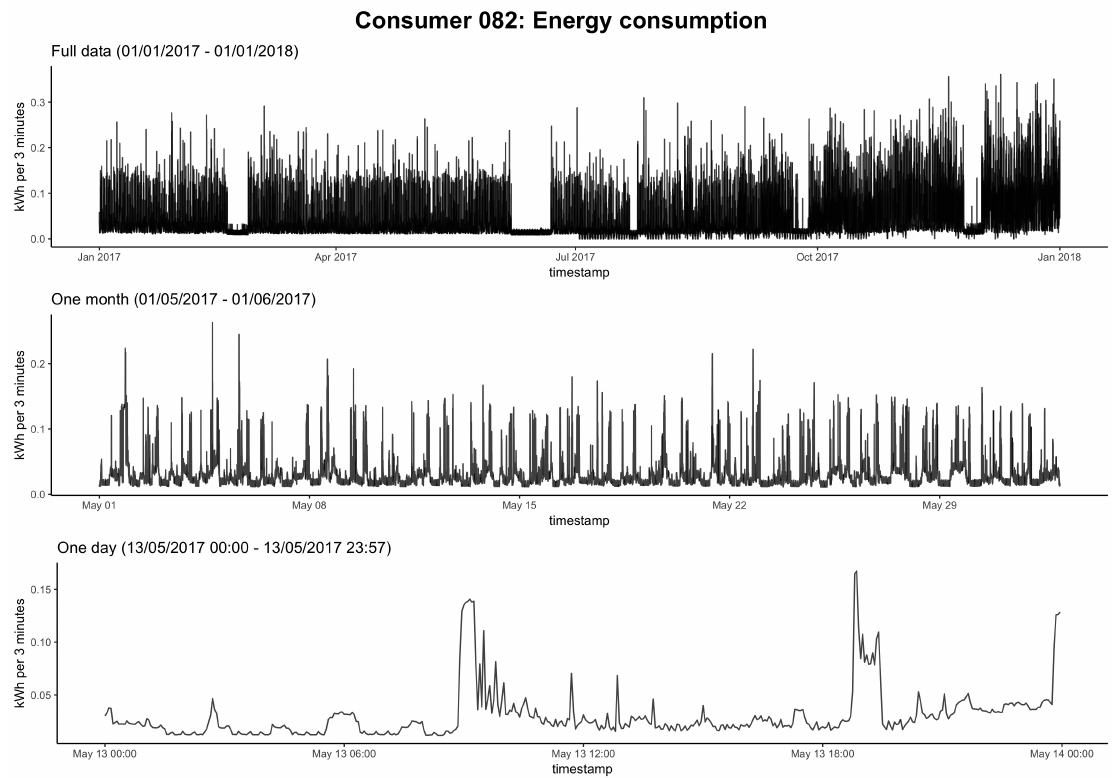
Figure 3. Energy consumption recordings of Consumer 082. The first panel shows the full year 2017, the second panel zooms in to one month (May), and the third panel zooms in to one day (13 May). BLEMplotEnergyData